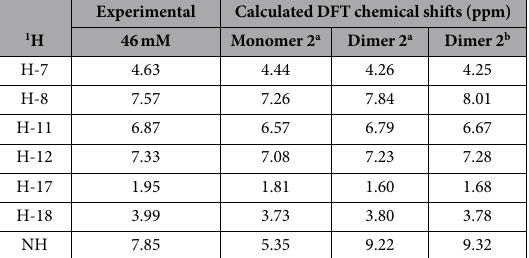
Table 6. Selected experimental and DFT calculated proton chemical shifts for Monomer 2 and Dimer 2 compared to the 46 mM colchicine in chloroform. a Calculated chemical shifts using mpw1pw91/6-311 + g(2d,p). b Calculated chemical shifts using wB97XD/6-311 + g(2d,p).